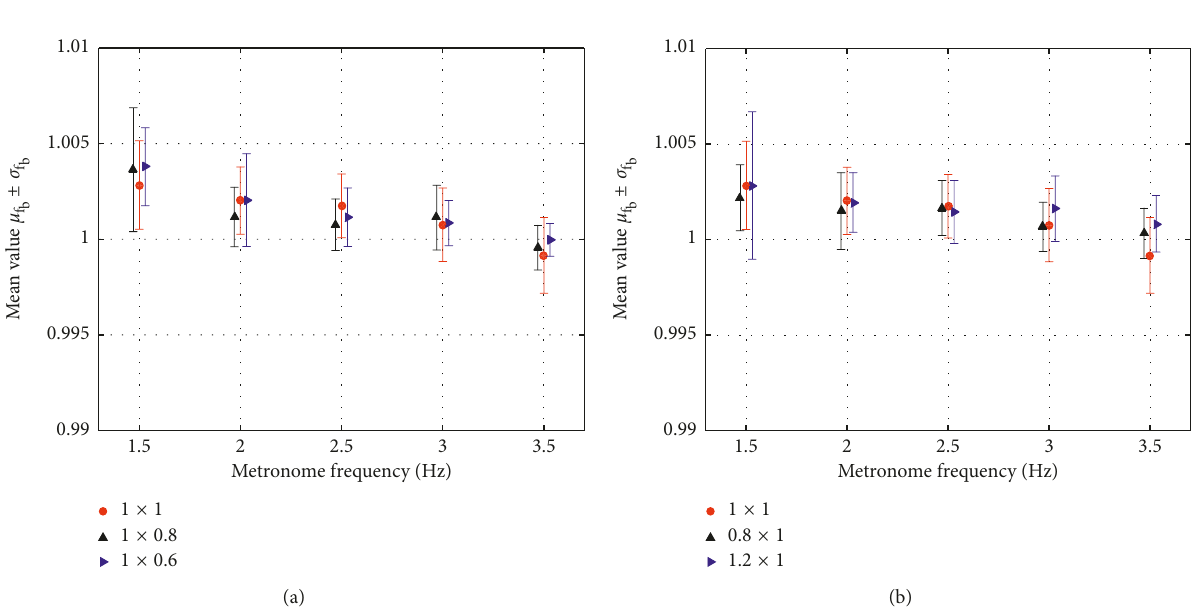
Figure 26: Comparison of normalized achieved bouncing frequency with three configurations in two groups. (a) Group 01 with different lateral distances; (b) group 02 with different frontal